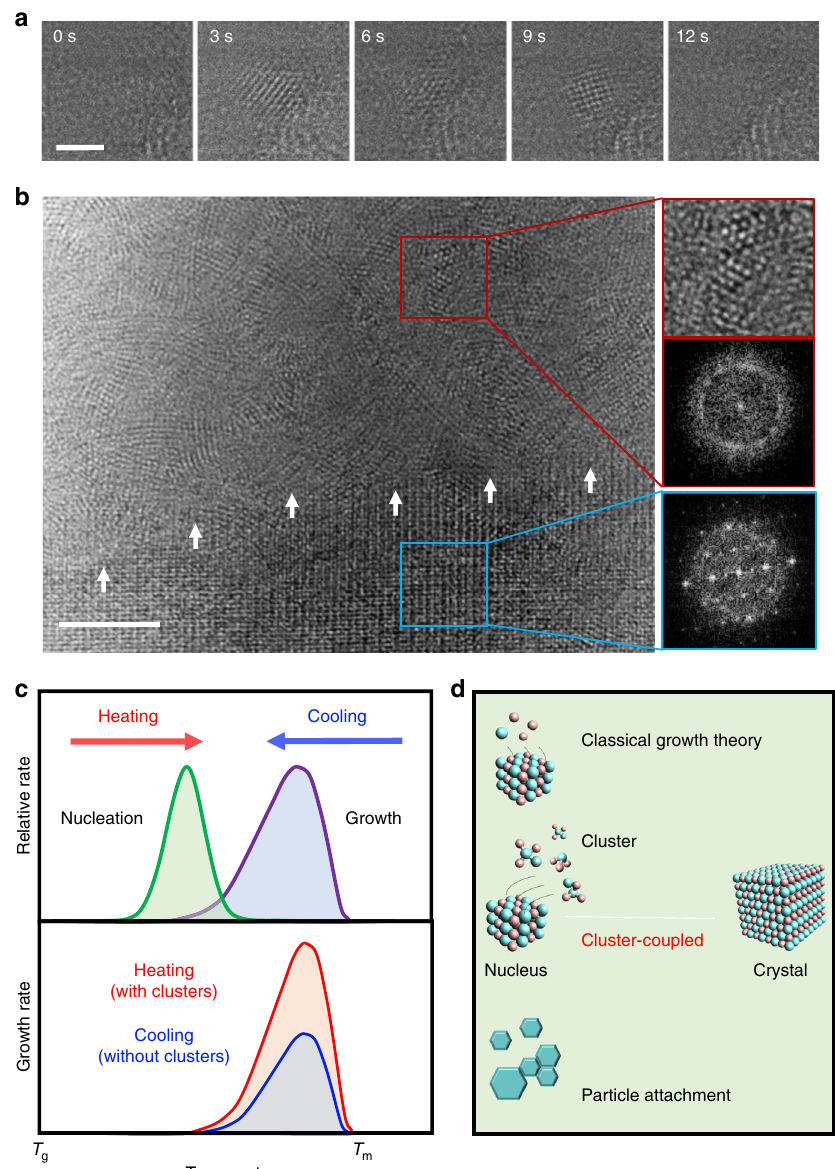
Fig. 5 Presence of small clusters and the proposed cluster-coupled growth mechanism. a TEM images from isothermal crystallization (Supplementary Movie 4) showing a cluster in a 20nm MG nanorod at 340°C. A cluster forms, rotates, and disappears within 6s at 340°C. The scale bar is 2nm. b A zoom-in area of a 35nm-diameter MG nanorod during isothermal crystallization from the glass state at 340°C (Supplementary Movie 5). Clusters with widths around 2nm exist in the amorphous region (cropped image in red box) and persist for several tens of seconds despite the high temperature of 340°C. The scale bar is 3nm. c Schematics that describe the classical theory of crystal growth (top) and a modi fi ed description of crystal growth in which small clusters can enhance the growth (bottom). d Schematic illustration showing different growth pathways, including the proposed cluster-coupled